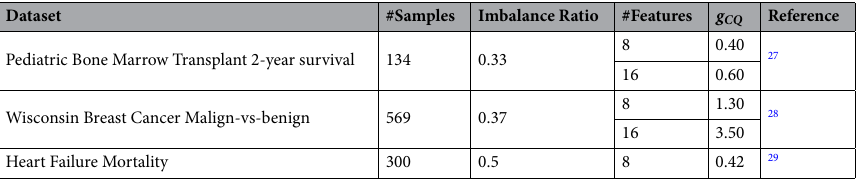
Table 1. Clinical datasets utilized for the study with their sample and selected feature count as well as their imbalance ratios and quantum advantage scores ( g CQ ) . Given a two-class dataset, the imbalance ratio ( IR ) is IR = x / y , where x is the number of minority class and y is the total number of samples. Furthermore, g CQ measures the similarities of quantum kernel and linear classical kernel functions of the same